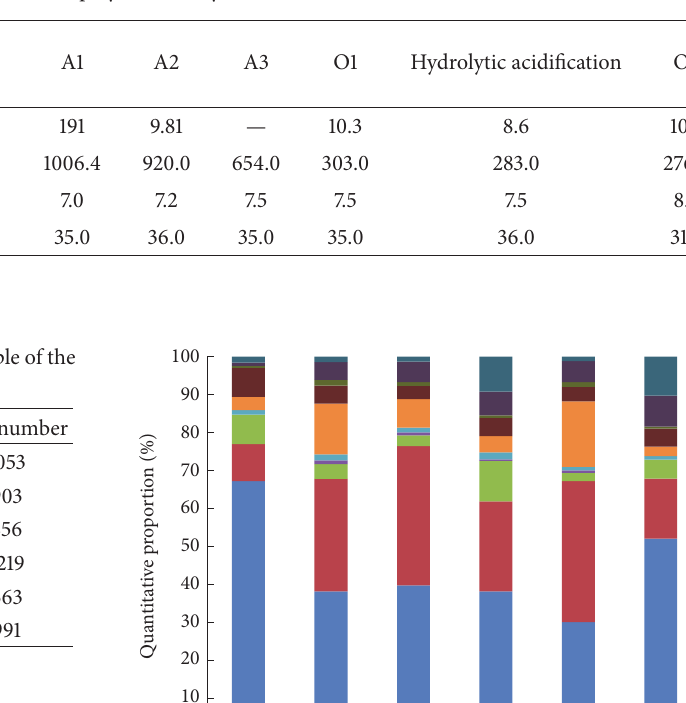
Table 4: Quality index of polyformaldehyde wastewater.